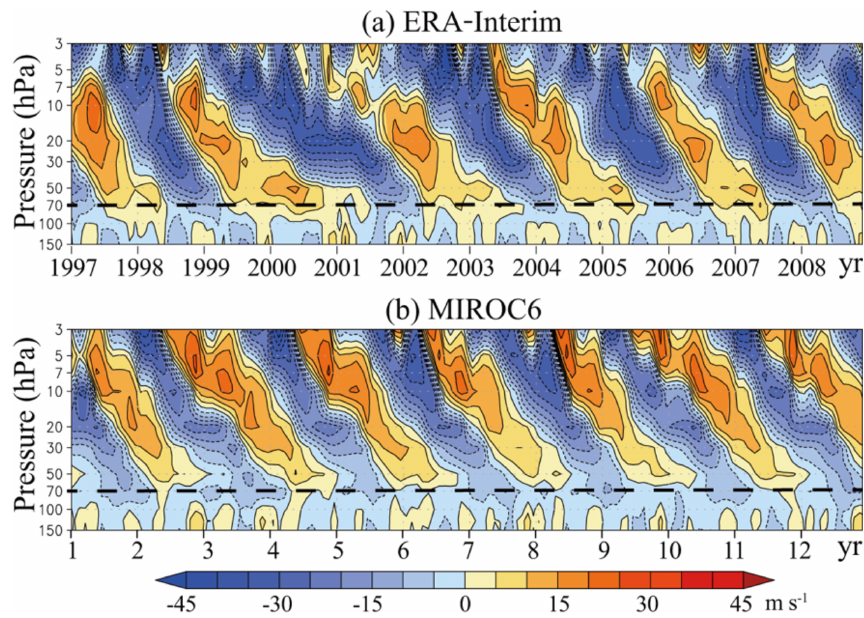
Figure 23. Time–height cross section of the monthly mean, zonal-mean zonal wind over the Equator for (a) observations (ERA-I) and (b) MIROC6. The contour intervals are 5ms − 1 . Dashed lines correspond to the altitude of the 70hPa pressure level. Red and blue correspond to westerlies and easterlies,